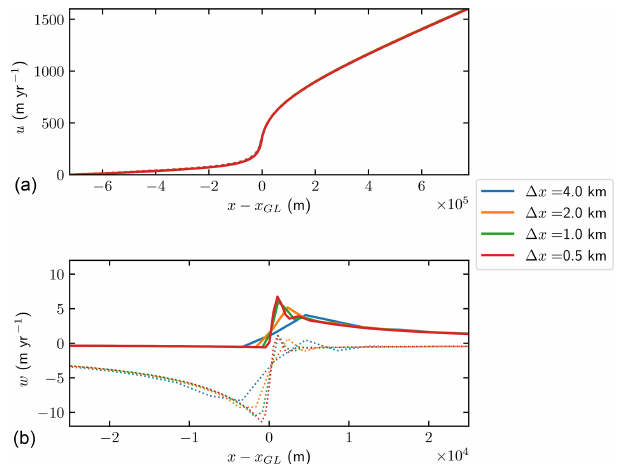
Figure 8. The velocities u (a) and w (b) of the ice in the advance experiment with (cid:49)x = 0 . 5, 1, 2, and 4km after 10000 years. The solutions at the upper surface are the solid curves, and the solutions at the lower surface are the dotted curves. The vertical velocity w is zoomed in close to the GL, with the distance to the mesh-dependent GL on the x